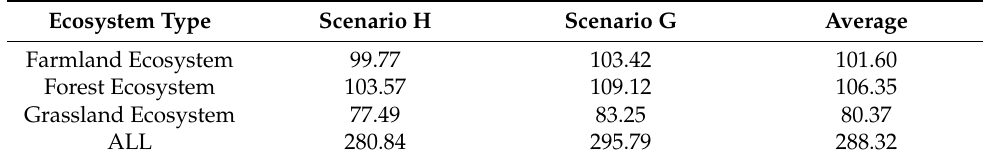
Table 2. WCA of the Hanjiang watershed and major ecosystems (mm).